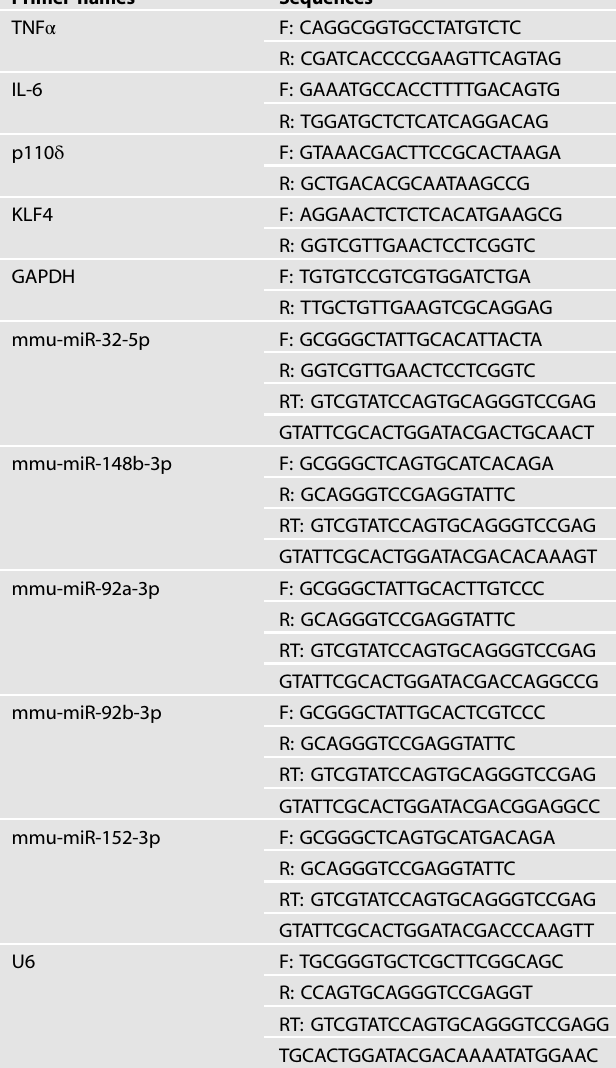
Table 1. Primers for cDNA synthesis or qPCR detection of